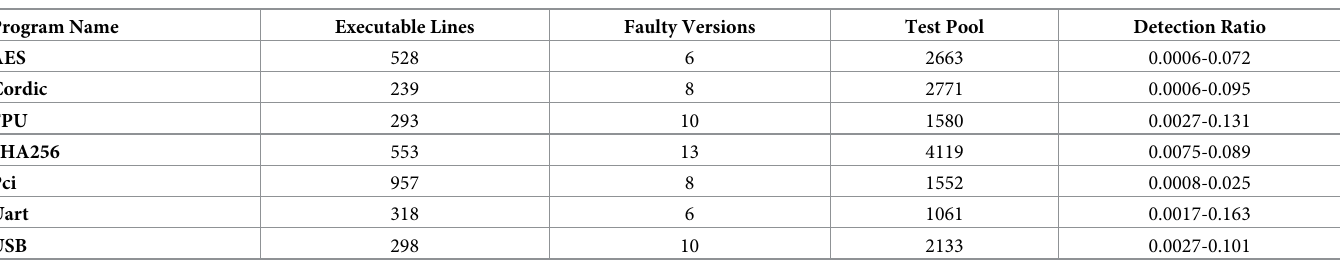
Table 2. Test suite information.